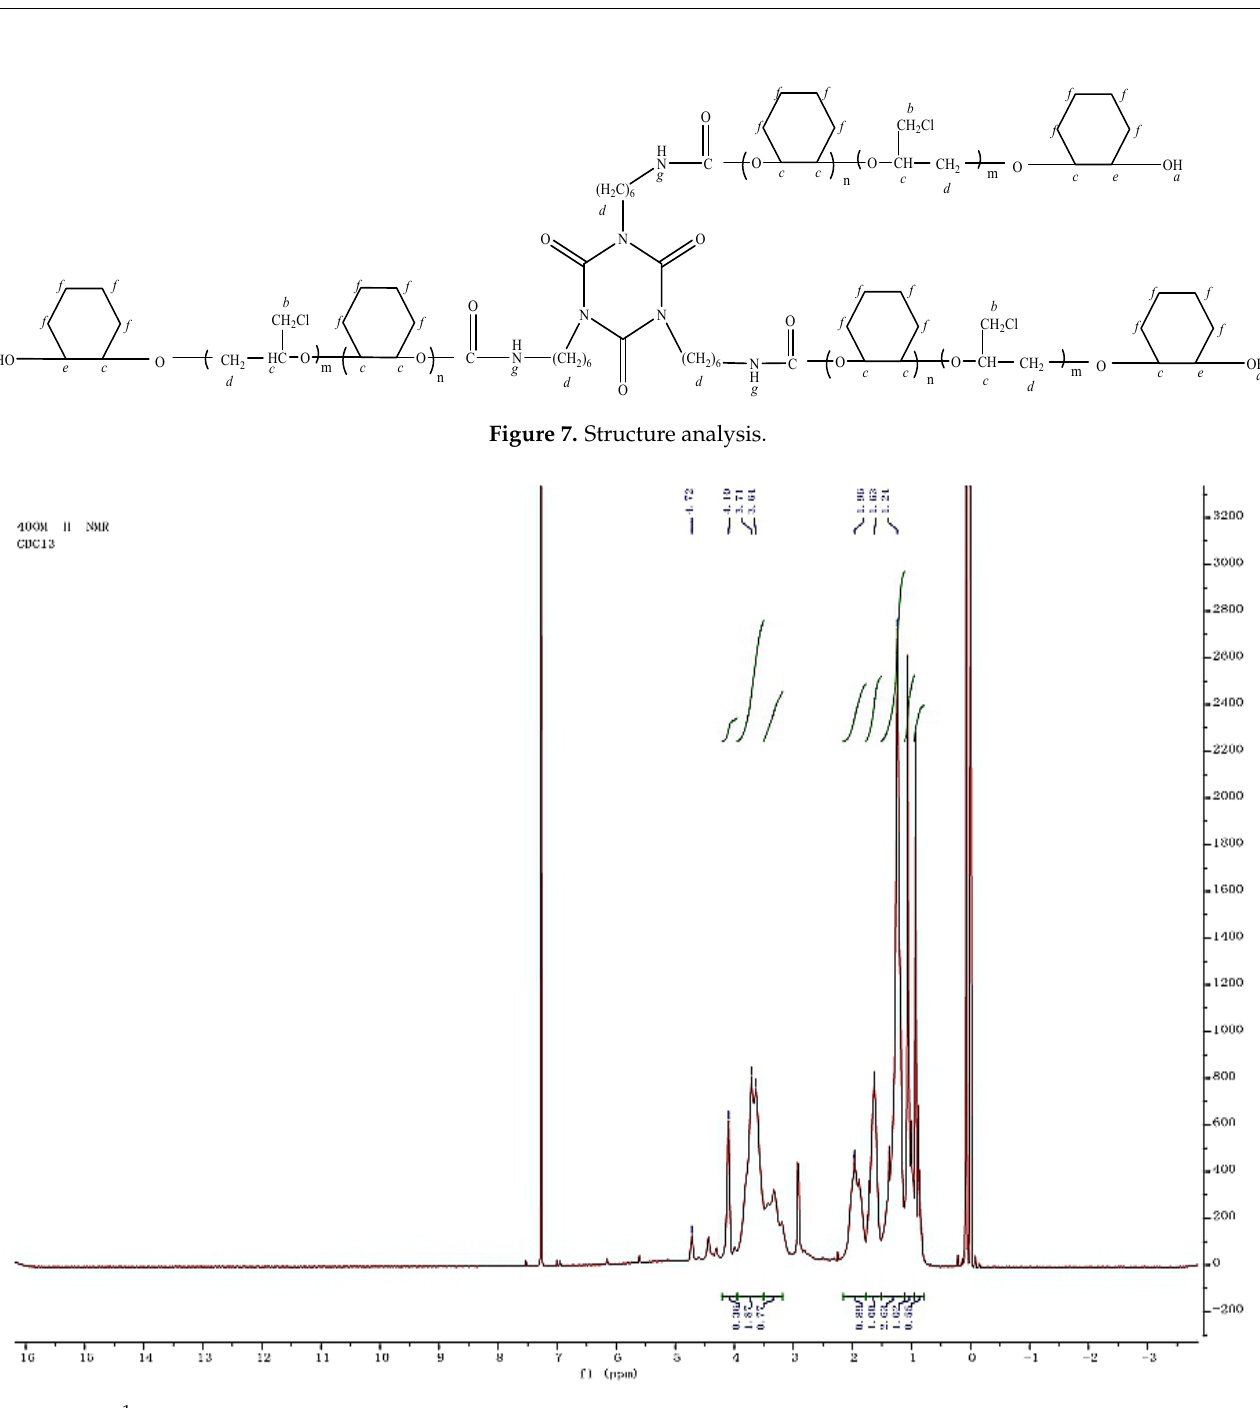
Figure 8. 1 HNMR of the synthetic polyurethane(dissolving in CDCl 3 , tetramethylsilane as an internal standard, 400 MHz of resonance frequency).